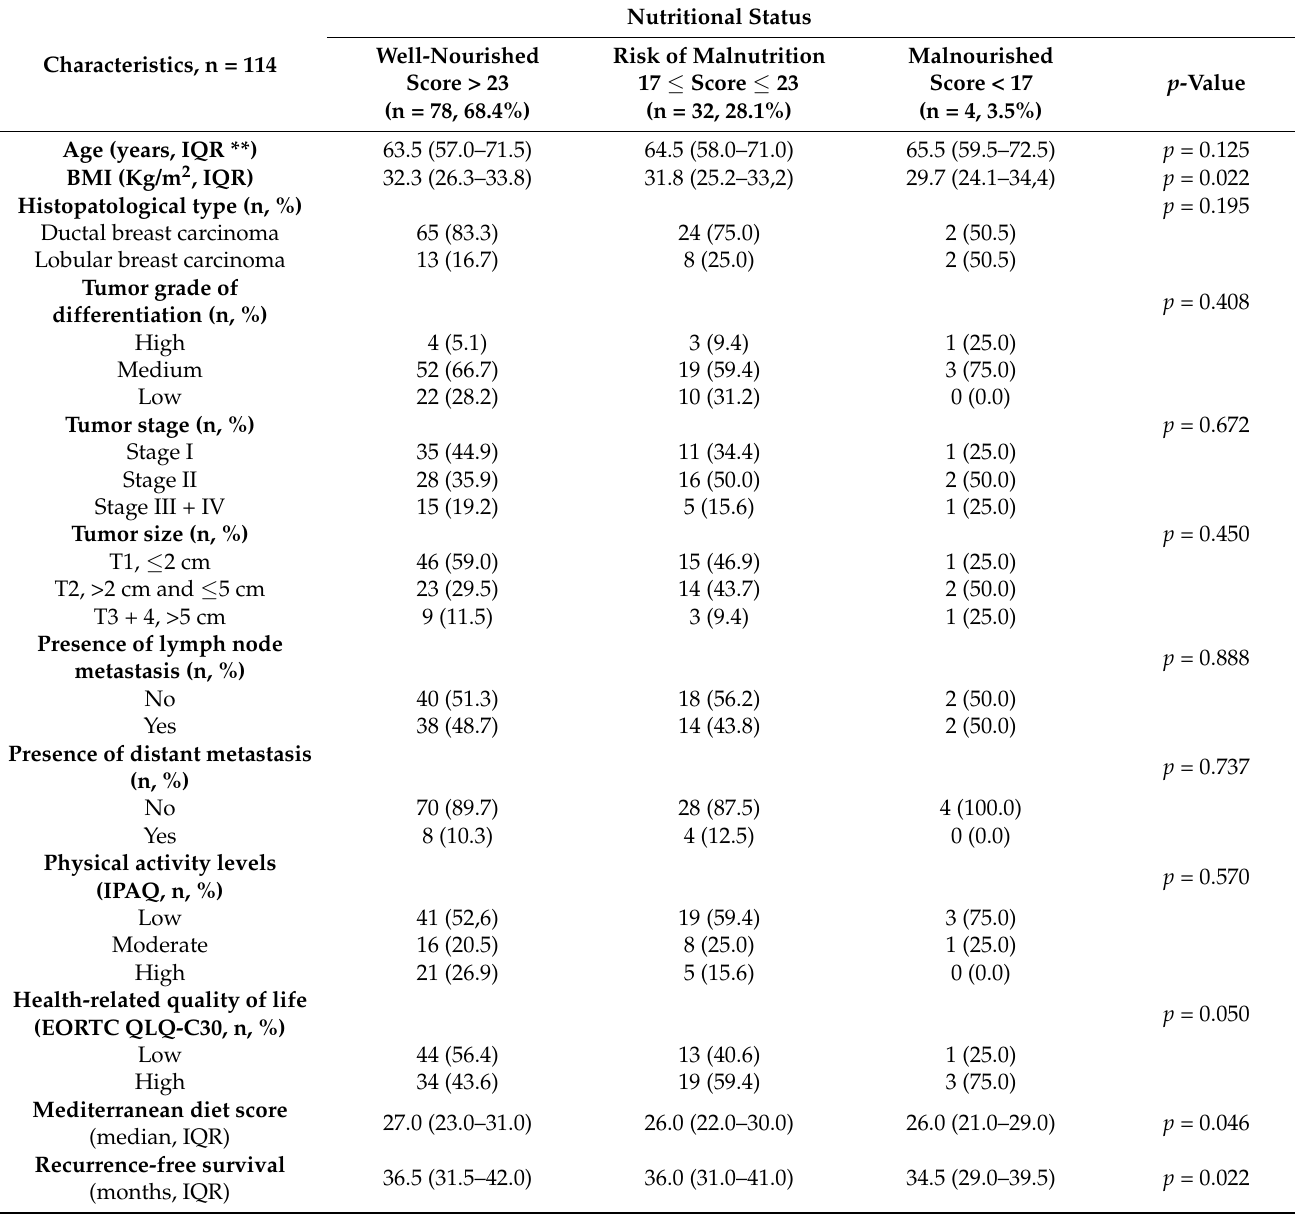
Table 2. Associations between examined characteristics and nutritional status according to MNA